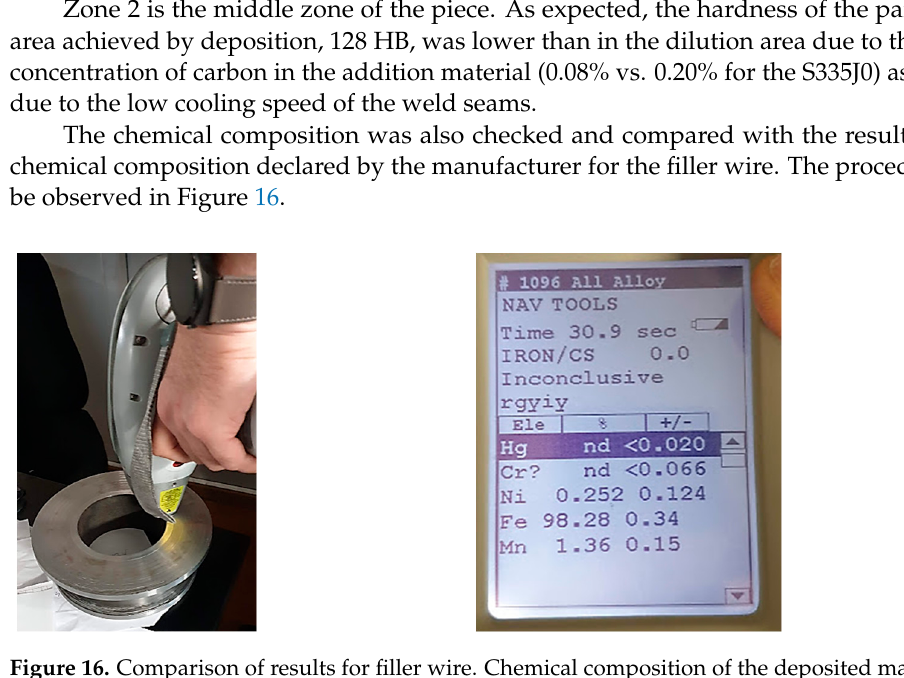
Figure 17. Sample sampler from the champion piece. Another step was milling of the test tube presented in Figure 18, a step that was needed to prepare the sample for microscopic tests. The following step was to cut and adjust the sample for embedding in resin (step presented in Figure 19).